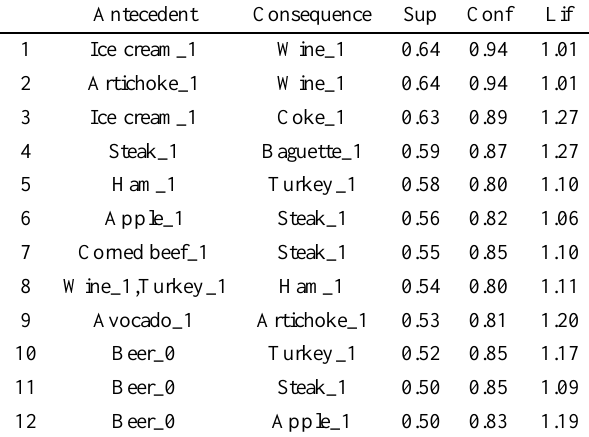
Table 3. Mining result of the newly presented market